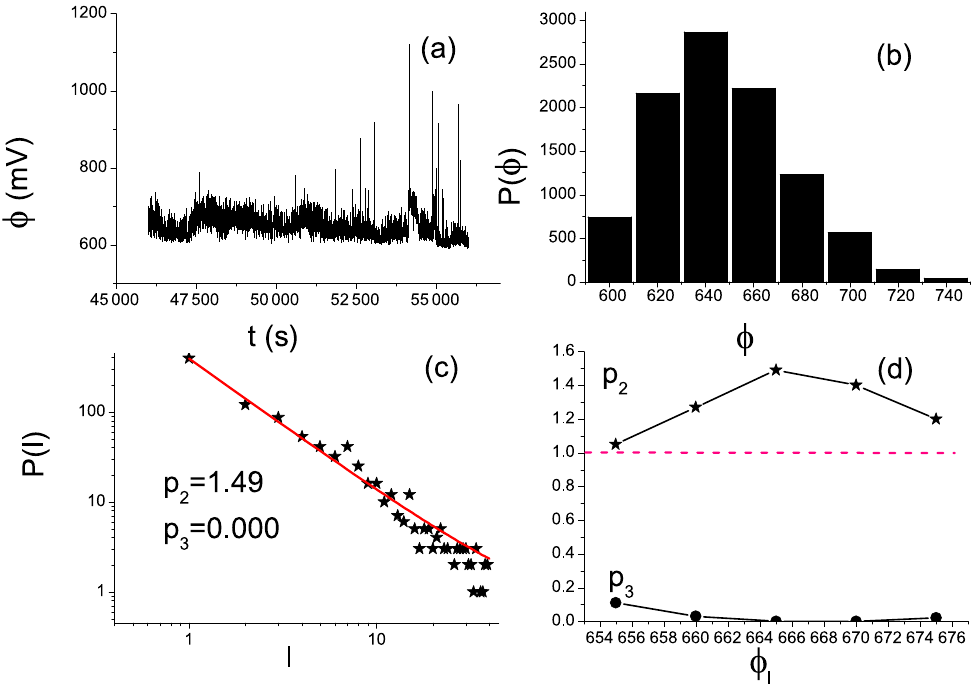
Figure 3. (a) The 10000-sample long critical window of the MHz EME that was recorded prior to the Cephalonia M w = 6 . 0 EQ at the Zante station, while (b) , (c) , and (d) are similar to the corresponding parts of Fig. 2. From (b) , a fixed point (start of laminar regions) φ o of about 600mV results, while in (c) , the distribution of laminar lengths is given for the end point φ l = 665mV for which the exponents p 2 = 1 . 49, p 3 = 0 . 000 with R 2 = 0 . 999 were